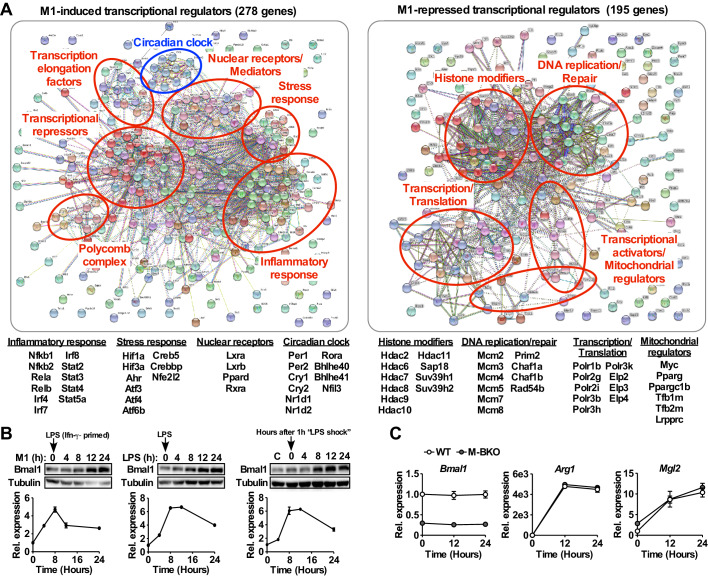
The circadian clock is a transcriptional module that is induced by M1 activation.(A) Annotated protein–protein interaction maps generated by STRING of transcriptional regulators that were significantly induced (left) or repressed (right) in WT macrophages by 8 hours M1 activation (Ifn-γ priming followed by stimulation with 10 ng/mL LPS) compared to time-matched controls (Ifn-γ priming without LPS), determined by RNA-seq (p<0.05, FDR <0.05, |F.C.|>1.5). N = 3 biological replicates. F.C., fold change. See Table 1 for the complete gene list. (B) Bmal1 protein levels (top panels) and relative gene expression determined by qPCR (bottom panels) in mouse embryonic fibroblasts during a 24-hr time course of M1 activation (10 ng/ml Ifn-γ overnight priming + 10 ng/ml LPS, left panels), treatment with LPS only (100 ng/ml, middle panels), or 1 hr acute LPS treatment (100 ng/mL, right panels). For M1- and LPS-only treatments, LPS was spiked in at time zero without medium change. For acute LPS treatment, cells were grown with LPS for one hour followed by culture in DMEM, 2% FBS without LPS (time zero indicates medium change). N = 3 biological replicates for qPCR. (C) Gene expression during a 24-hr time course of Il-4 treatment in WT and M-BKO macrophages determined by qPCR. N = 3 biological replicates. Data are presented as mean ± S.E.M. *, p<0.05. Cell culture experiments were repeated at least twice.